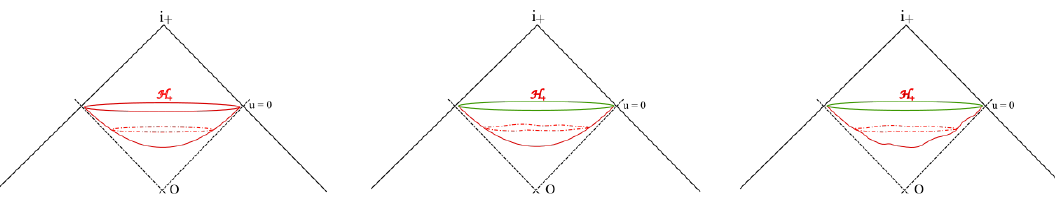
Figure 3 . The EoW brane and its fluctuations. (a) is a fixed AdS 2 brane. (b) shows a rigid brane with spatial fluctuations. (c) shows fluctuating brane configuration. The green circle denotes the fixed metric at the boundary due to Dirichlet boundary